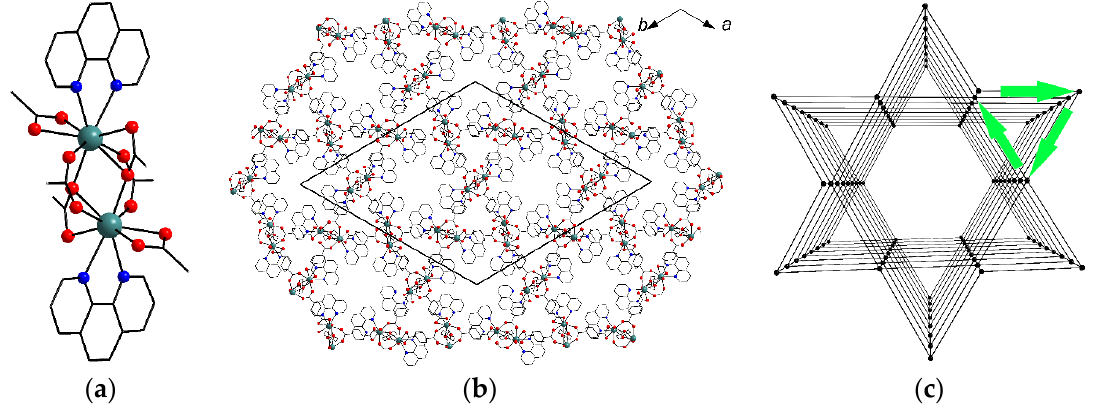
Figure 5. Binuclear block {Nd 2 (phen) 2 (OOCR) 6 } in the structure of 3 ( a ) and view along c crystallo- graphic axis ( b ). Atom colors correspond to Figure 4; guest molecules are not shown. Topological representation of the coordination lattice in 3 ( c ). Binuclear block {Nd 2 (phen) 2 (OOCR) 6 } is shown as a black node. Green arrows show a helical structure of trilateral channels in the net.